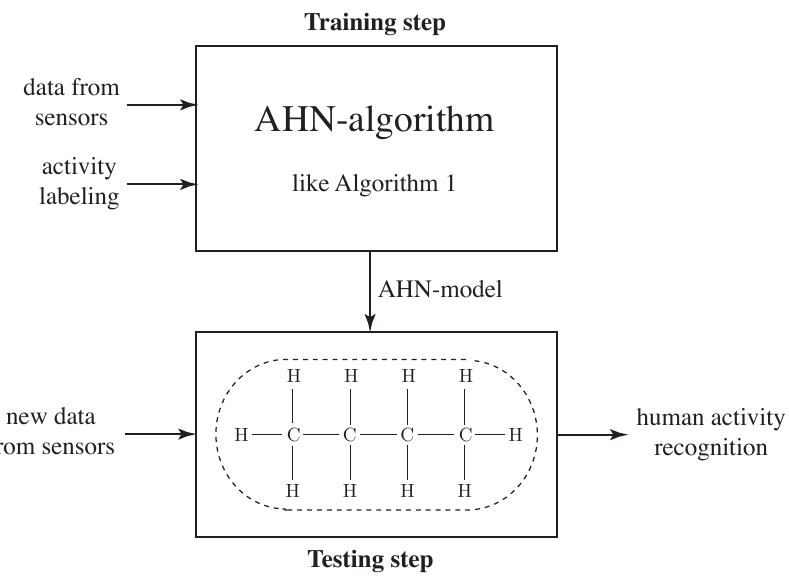
Figure 2. Diagram of the proposed artificial hydrocarbon network-based classifier (AHN